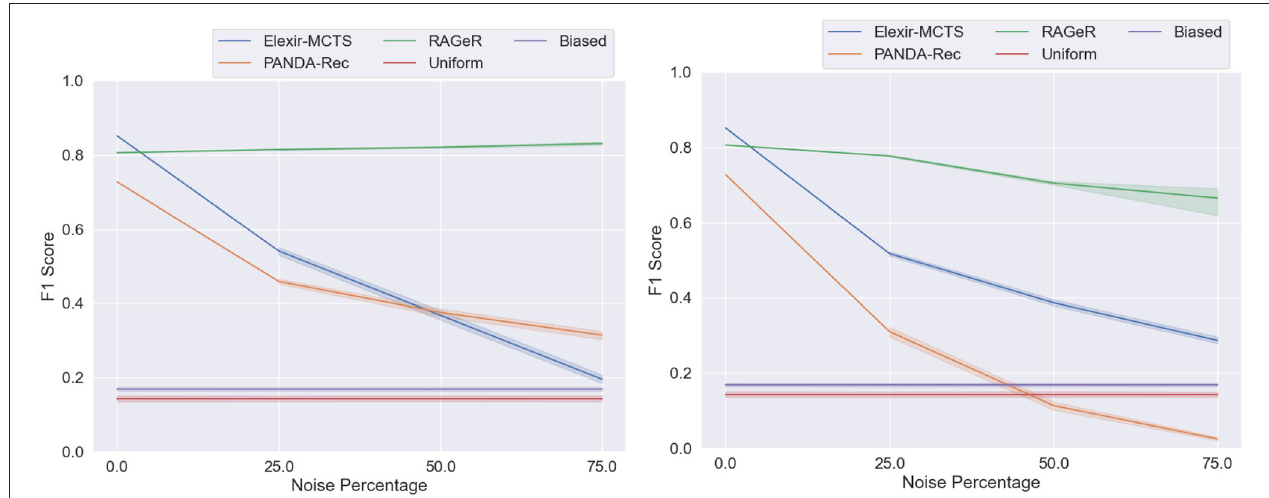
FIGURE 8 | Performance of PANDA-Rec, Elexir-MCTS, RAGeR, and two baselines (Random Uniform and Random Biased Recognition) over unreliable traces from the Minecraft domain. Figures represent the performance of methods with regards to unreliability resulting from missing actions (left) and incorrect actions (right) . We varied the noise percentage from 0 to 75% in increments of 25%, and all methods were run for 10 runs for each noise percentage (excluding 0% noise). Each line represents a 95% confidence interval for the average macro F1 scores over the 10